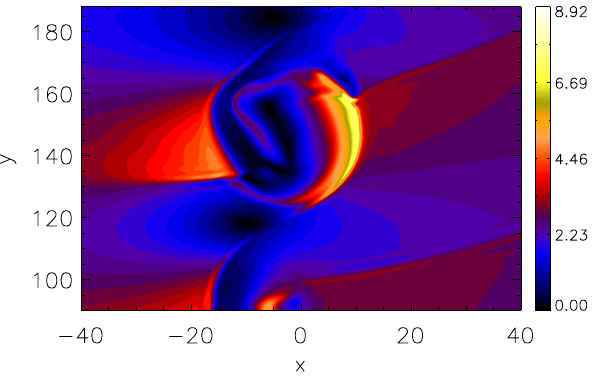
Fig. 5. Shaded density isocontours at t = 330, V 0 = 4 . 6. White curves represent magnetic field lines in the